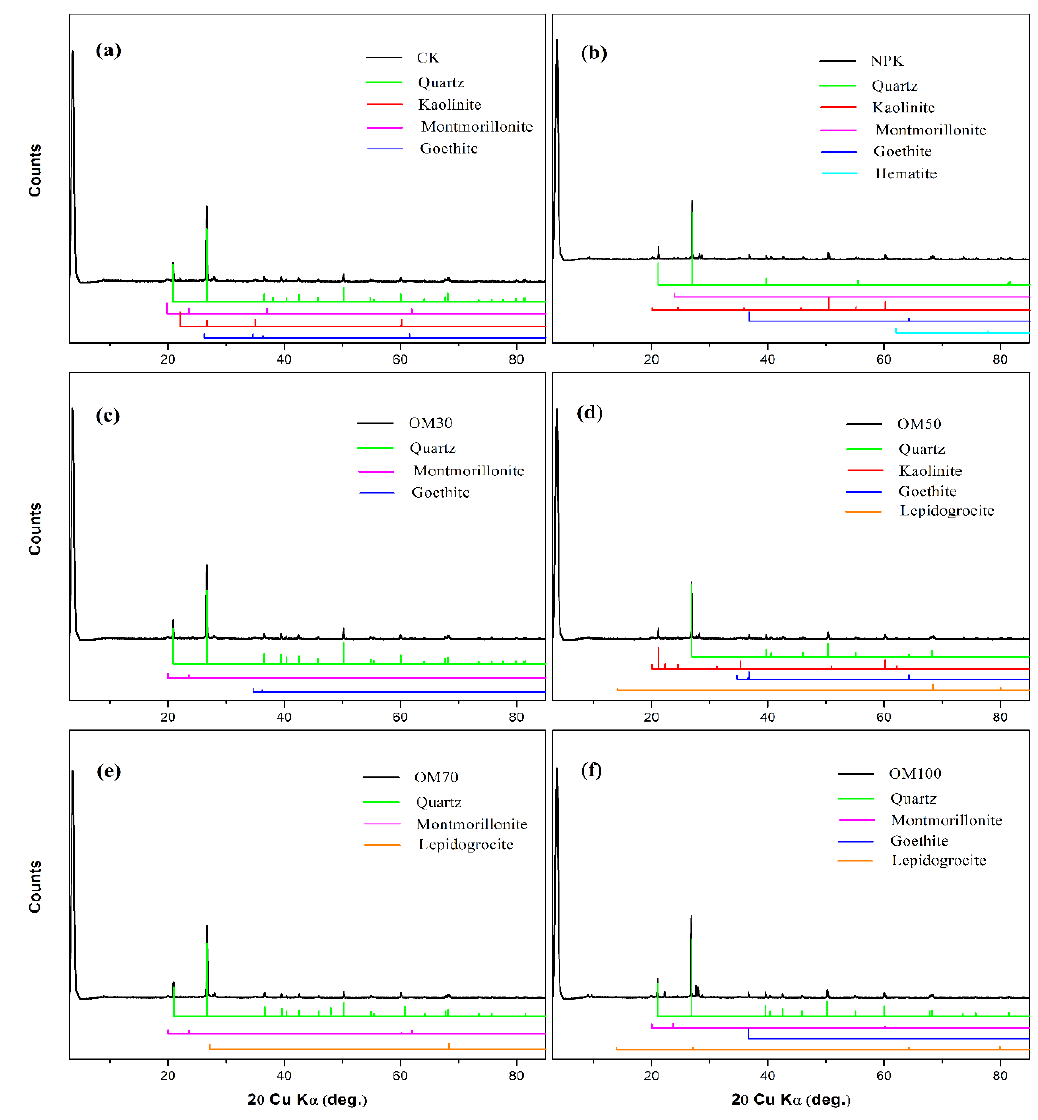
Figure 5. XRD spectra of all treatments (( a ) CK, ( b ) NPK, ( c ) OM30, ( d ) OM50, ( e ) OM70, and ( f ) OM100). Table 4. The chemical properties of soil treated with different fertilizers (mean ± standard error).